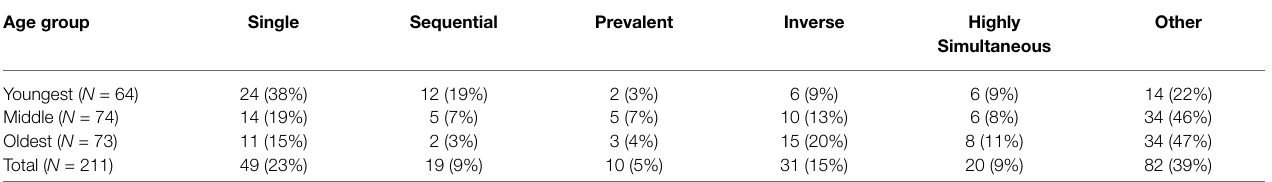
TABLE 3 | The number and percentage of the coded AES positive and negative interaction patterns when all emotions are included. Age group Single Sequential Prevalent Inverse Highly